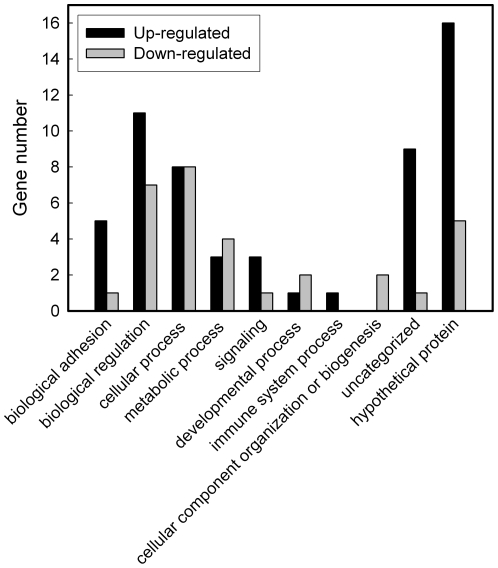
Biological processes correlated with the EF-regulated genes.The significantly regulated genes listed in Table 2 (up-regulated) and Table 3 (down-regulated) were categorized with their biological function according to the Gene Ontology annotation.